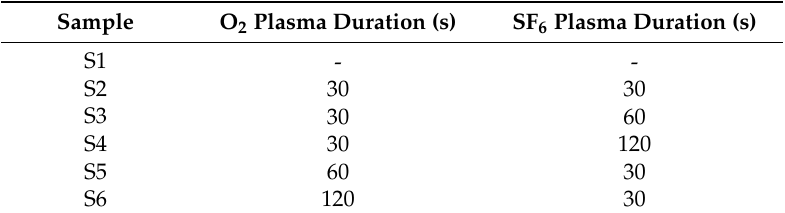
Table 2. Samples for stability measurement.